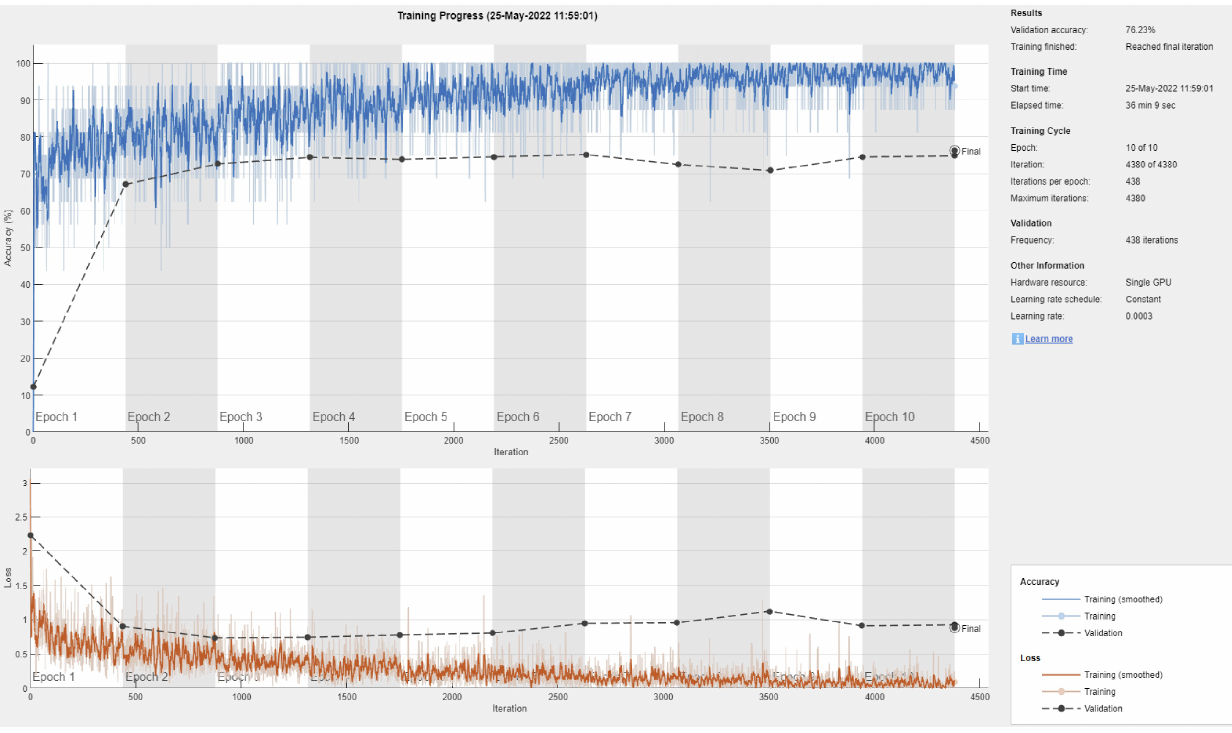
Figure 3. Sample training/validation progress curve for Resnet101 and 70/30 data